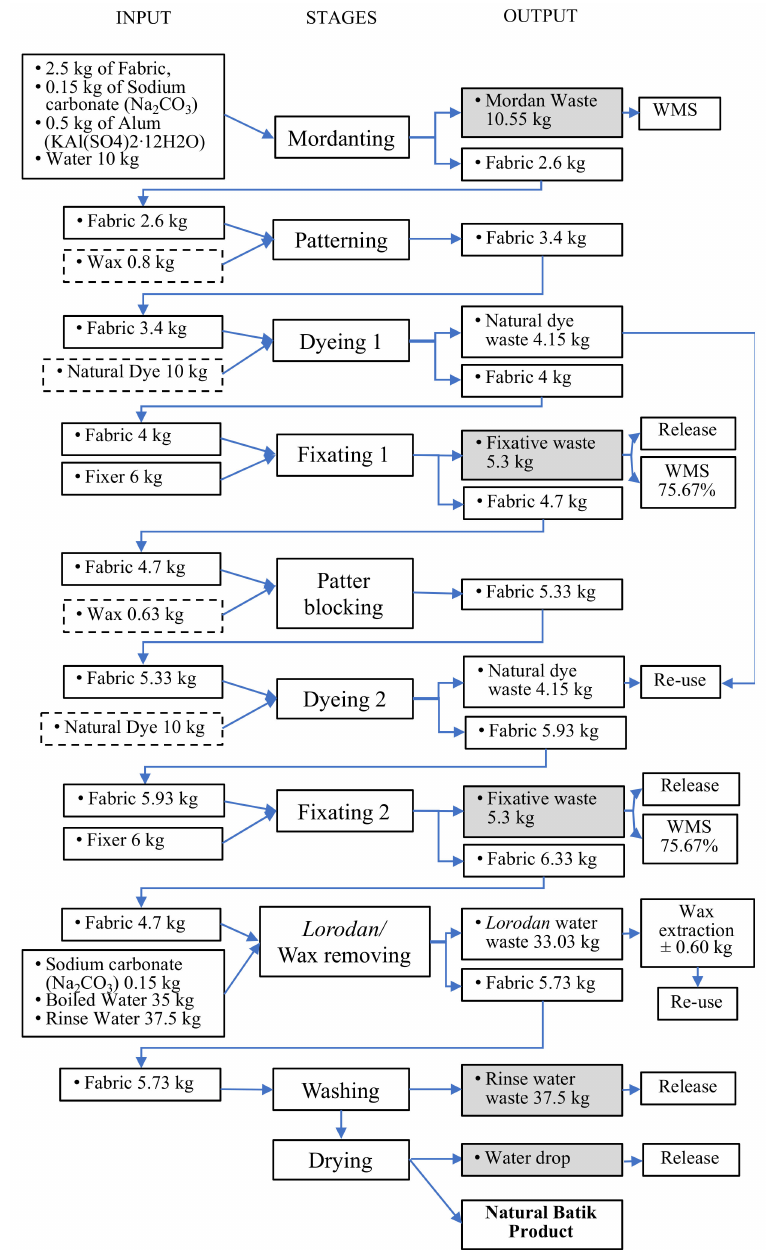
Figure 4. Natural dye batik-producing process in Zie Batik. The boxes with dotted lines represent a biodegradable component, and the grey boxes represent a water waste by-product. WMS: water waste management